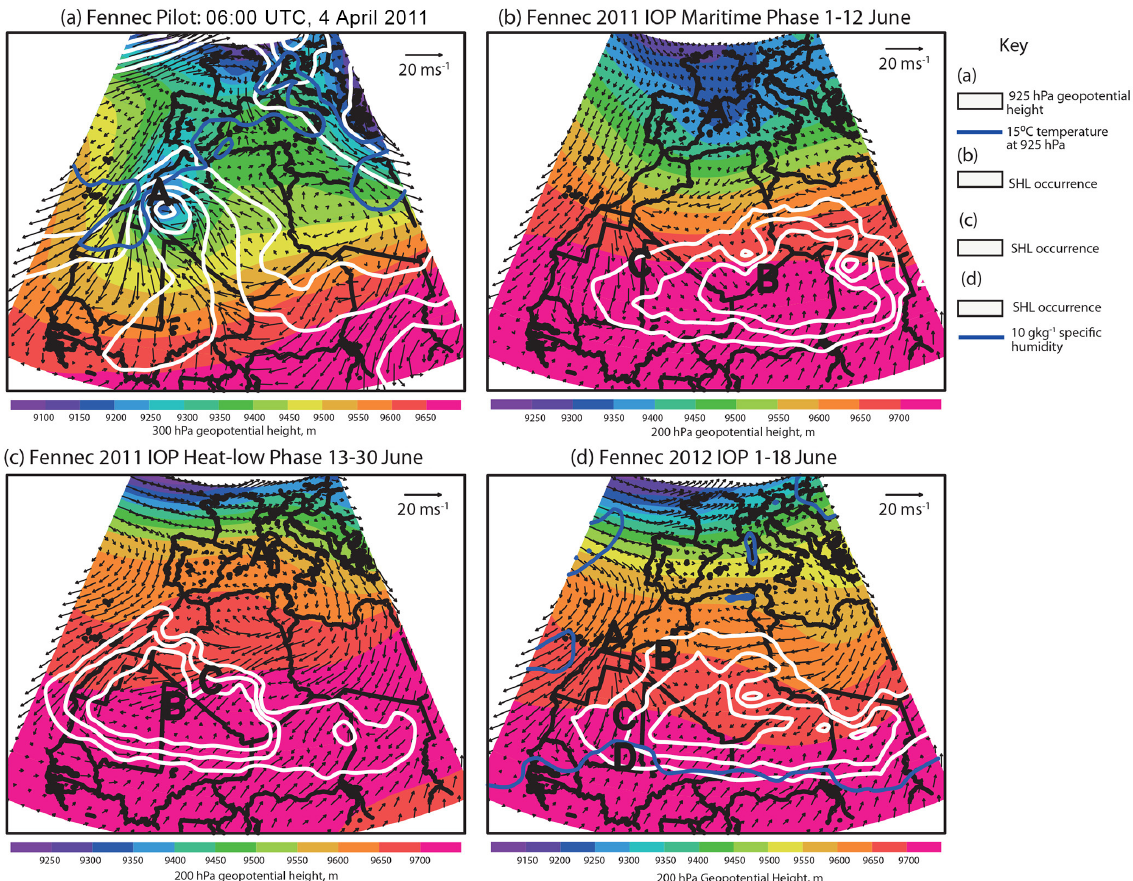
Figure 3. Synoptic conditions during the Fennec flight campaigns. (a) 300hPa (m, shaded), 925hPa geopotential height (white contours with intervals at 700, 725, 750 and 800m), 925hPa winds (ms − 1 ) and 15 ◦ C contour of 925hPa temperature (blue line) to show cold air advection, at 06:00UTC 4 April 2011. Feature A marks the position of the cut-off low. (b) Daily mean 200hPa geopotential height (m, shaded), 925hPa winds (ms − 1 ) and mean frequency of the SHL occurrence (white contours with intervals at 0.25, 0.5 and 0.75, as defined using the method of Lavaysse et al., 2009) averaged over the period 1–12 June 2011 (the maritime phase). Features A, B and C indicate the approximate locations of an upper-level trough, SHL centre and maritime low-level flow, respectively. (c) as (b) except for the period 13–30 June 2011 (heat low phase) and where features A, B and C indicate the approximate locations of an upper-level ridge, SHL centre and enhanced northeasterly harmattan level flow, respectively. (d) as (b) except for the period 1–18 June 2012, and a 10.0gkg − 1 925hPa specific humidity contour (blue line) and where features A, B, C and D indicate the approximate locations of an upper-level trough, SHL extension trough, maritime low-level flow and ITD bulge,